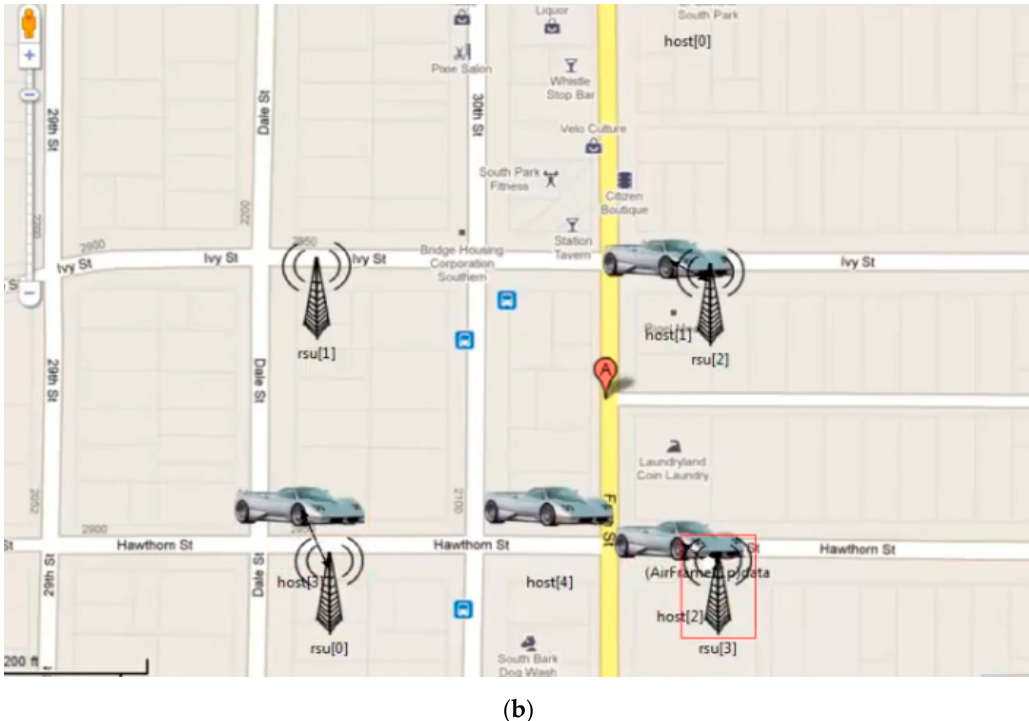
Figure 7. ( a ) Bandwidth allocation ongoing between the vehicles. ( b ). Bandwidth allocation and message passing between vehicles.